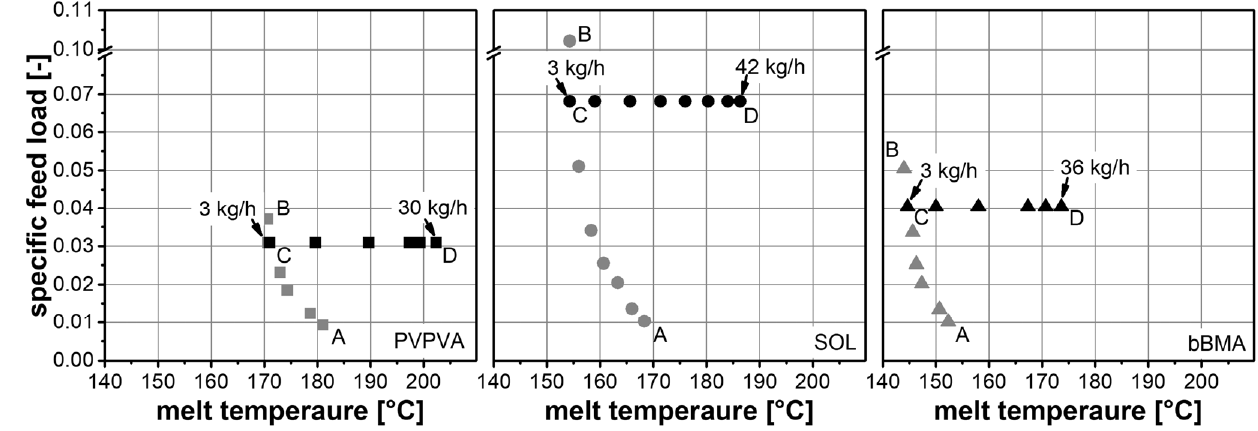
Figure 4. Results of the extrusion experiments. SIOS plots for PVPVA (square), SOL (circle) and bBMA (triangle). Determination of maximum specific feed load (gray) and determination of maximum throughput (black).